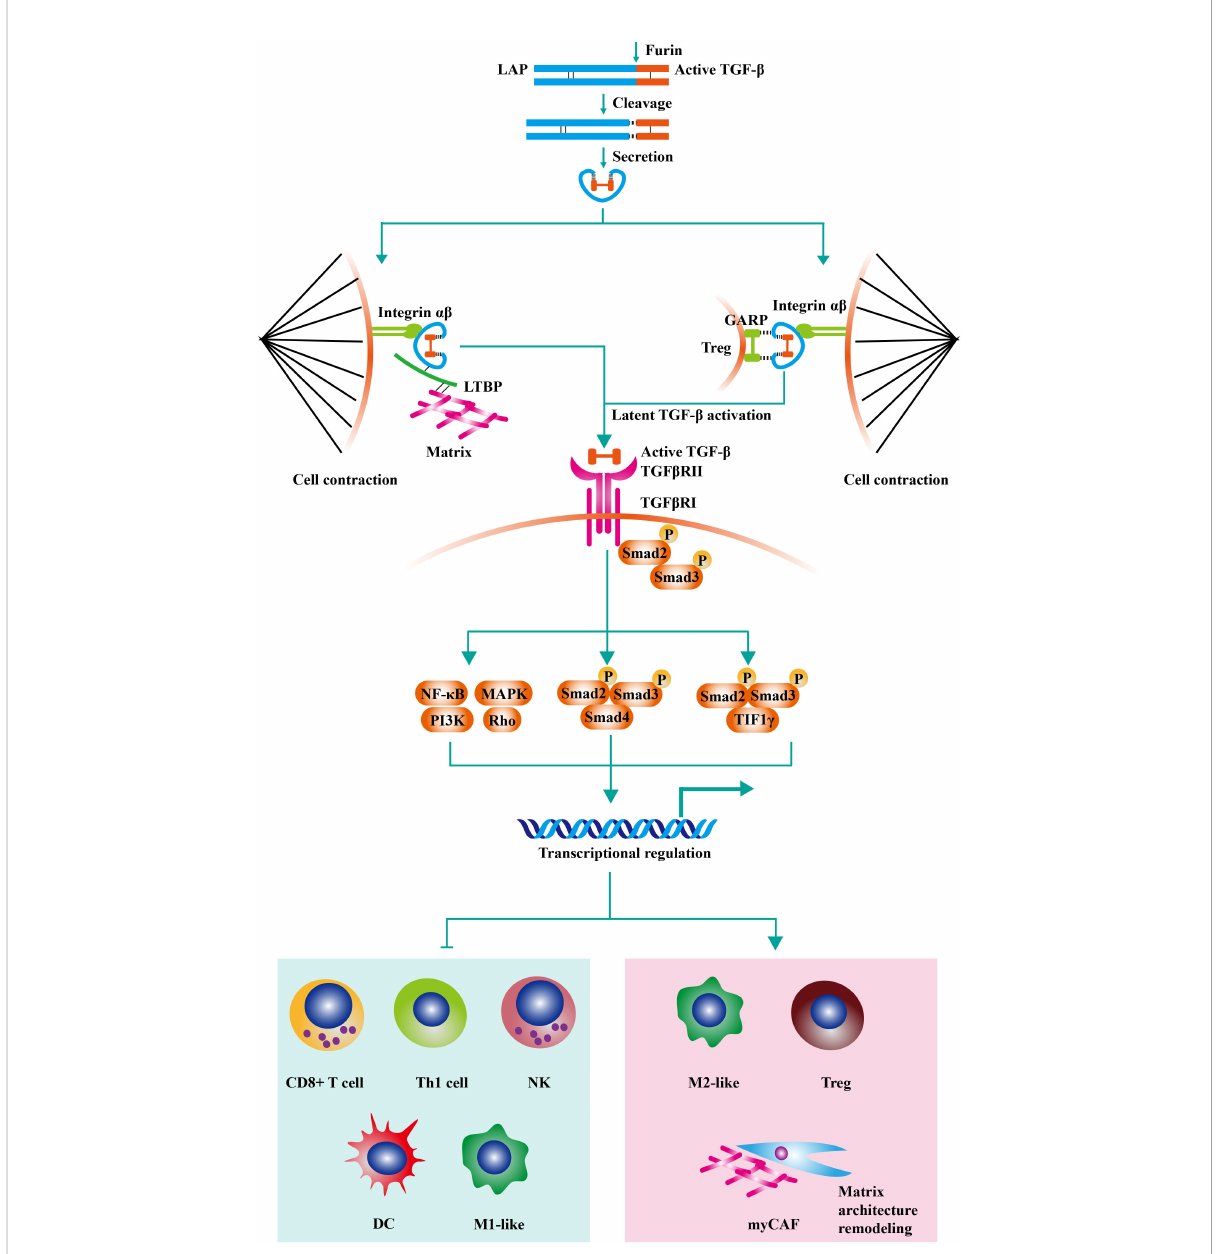
FIGURE 1 The negative effects of TGF- b signaling on anti-tumor immunity. Pro-TGF- b contains a long signal sequence, a long N-terminal sequence named latency-associated peptide (LAP), and a short C-terminal, which is the mature cytokine. Then, dimerized pro-TGF- b is cleaved by Furin (a protease) in Golgi complex. As a result, the bioactive TGF- b moieties are linked with LAP homodimer through disul fi de bonds. The LAP encircles bioactive TGF- b moiety and hampers the binding of TGF- b with its receptor. After secretion, The LAP homodimer could anchor to Glycoprotein A repetitions predominant (GARP) on Treg or crosslink with extracellular matrix by latent TGF- b binding proteins (LTBPs). Then, active TGF- b is released by integrin-transmitted forces when cell contraction. TGF- b signaling is triggered by the interaction of TGF- b ligands with TGF- b type II receptors (TGF b RII). Following the recruitment and phosphorylation of TGF- b type I receptors (TGF b RI) by TGF b RII, SMAD2 and SMAD3 are phosphorylated and further assembled into trimeric complexes with SMAD4. The SMAD complexes could translocate into cell nucleus and regulate the expression of TGF- b -targeted genes. TGF- b acts on various immune cells in the tumor microenvironment, inducing the generation of a suppressive immune microenvironment. On the one hand, TGF- b inhibits the cytotoxic activity of CD8 + T cells, CD4 + T cells, and NK cells. On the other hand, TGF- b increases the proportion of regulatory T cells (Treg) and M2-like macrophage. Moreover, recent studies have found that TGF- b modulates the activity of tumor-associated fi broblast (CAF) and increases the content of collagen fi bers in the tumor stroma (contributed mainly by myCAF). The thickened collagen fi bers surrounding the tumor tissue are detrimental to lymphocyte in fi ltration, resulting in an immune-excluded tumor type. Adapted from Bai et al, 2019